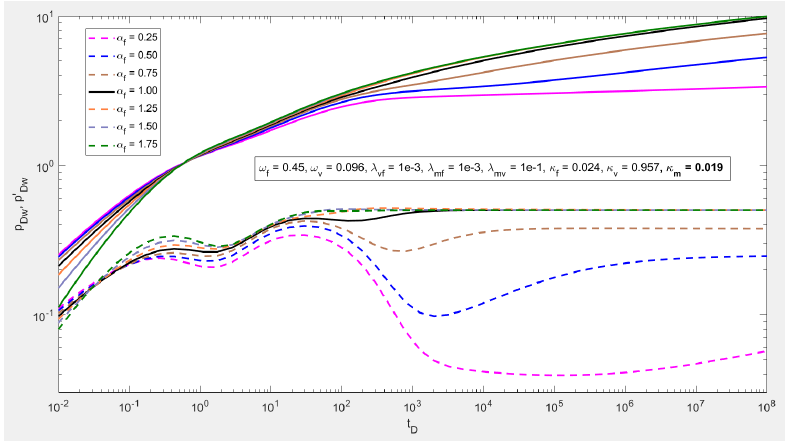
Figure 7. Effects of considering anomalous flow only in the fractured system, α v = 1, α m =